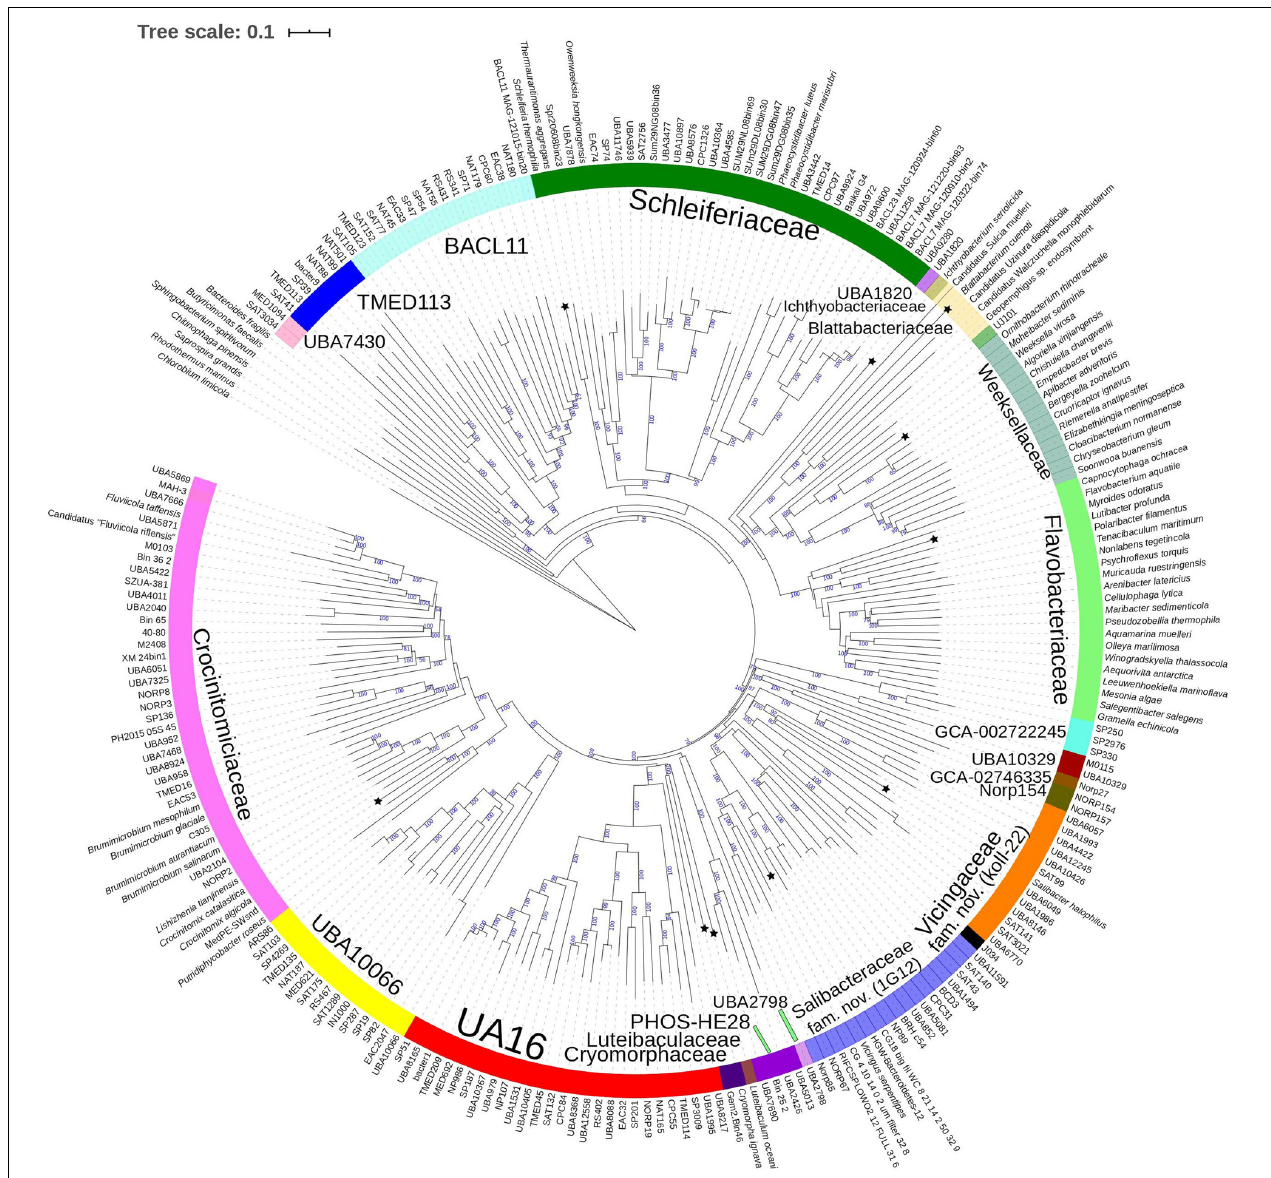
FIGURE 2 | GTDB Bac120 protein set based BioNJ tree focusing on sequences related to the family Cryomorphaceae and related taxa of the order Flavobacteriales , phylum Bacteroidetes . The tree is a consensus tree generated in IQ-Tree. Bootstrap values converted to a percentile scale are based on 200 replicates. Only bootstraps exceeding 50% are shown. Color strips indicate location of family-level lineages based on the GTDB framework. Family designations include the GTDB and the revised taxonomy determined in this study. Star symbols located on branches indicate validated described type strains relevant to this study. More detailed information on taxa compared is shown in Table 2 and Supplementary Table S1